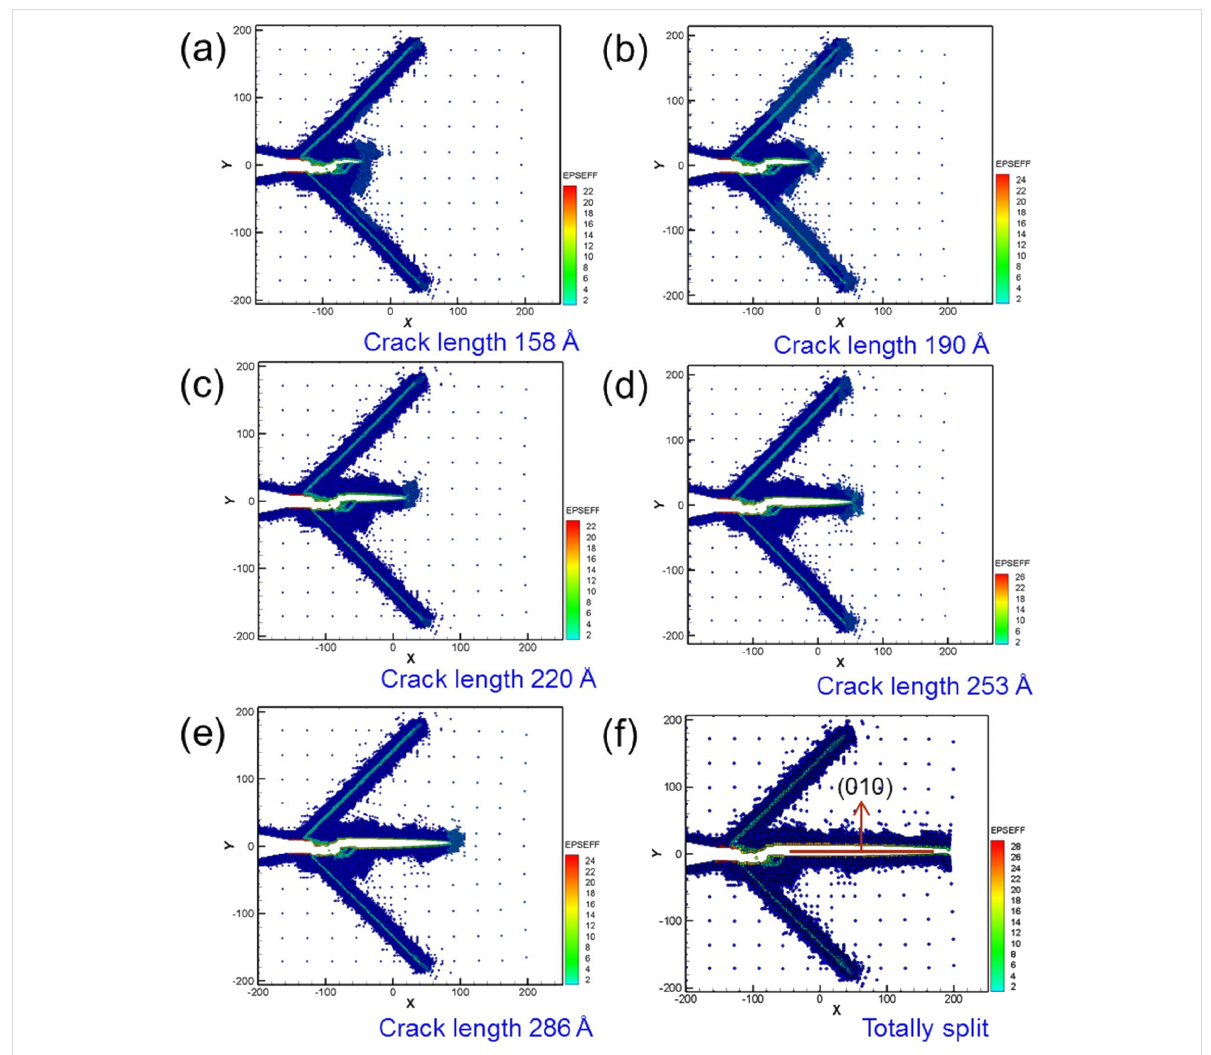
Figure 6: Crack growth and expansion diagrams of Ni corresponding to the observation positon a–f annotated in Figure 5.